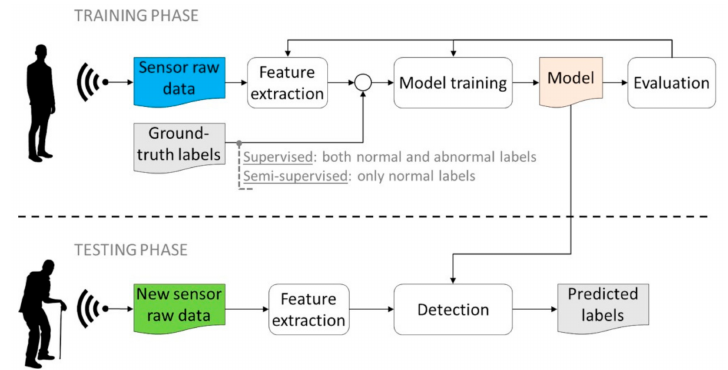
Figure 12. Workflow of supervised and semi-supervised detection methods. Both normal and abnormal labels are needed in the supervised training phase, whereas only normal labels are required in the semi-supervised